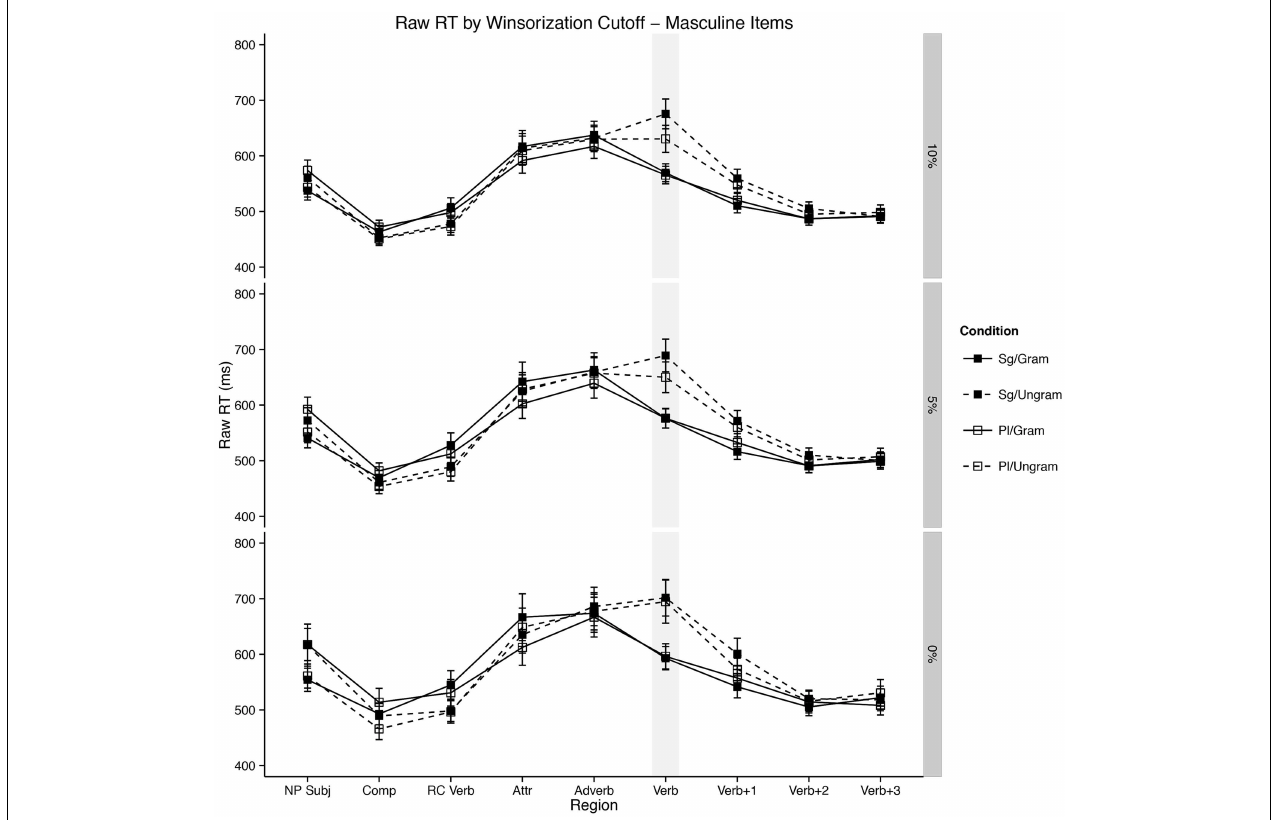
FIGURE 4 | Self-paced reading results. Region by region means of masculine items segregated by attractor number and verb number for three Winsorization cutoff thresholds. Error bars represent the standard error of the mean computed across subject